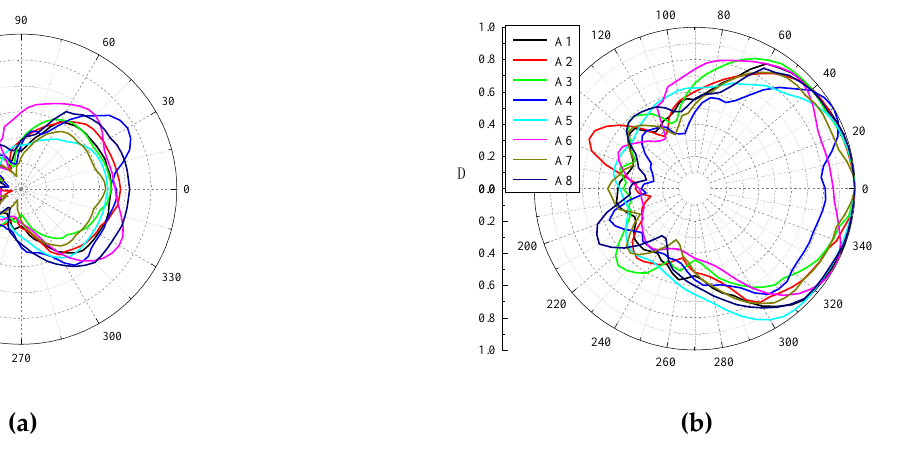
Figure 14. Horizontal directivity of azimuthal-transmitting piezoelectric vibrators. ( a ) Non-normalized horizontal directivity and ( b ) normalized horizontal directivity. Table 2. The transmitting piezoelectric vibrator is directly opposite to the hydrophone; and the peak-to-peak amplitude, dominant frequency, and peak-to-peak sound pressure of the time-domain waveform are measured. The main lobe width of − 3 dB is obtained by directivity measurement. The source distance between the transmitter and receiver is 2000